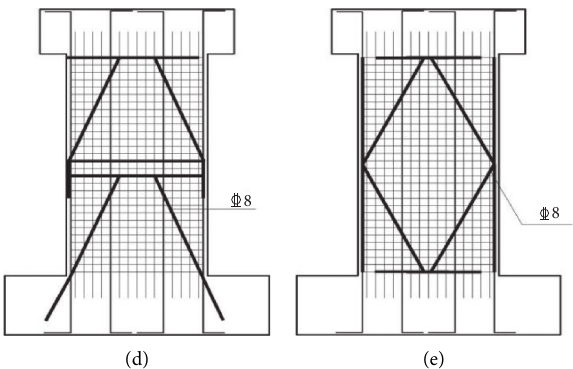
Figure 1: Composite wall size and reinforcement. (a) Section diagram of specimen W01 1-1. (b) Section diagram of specimen W02 1-1.